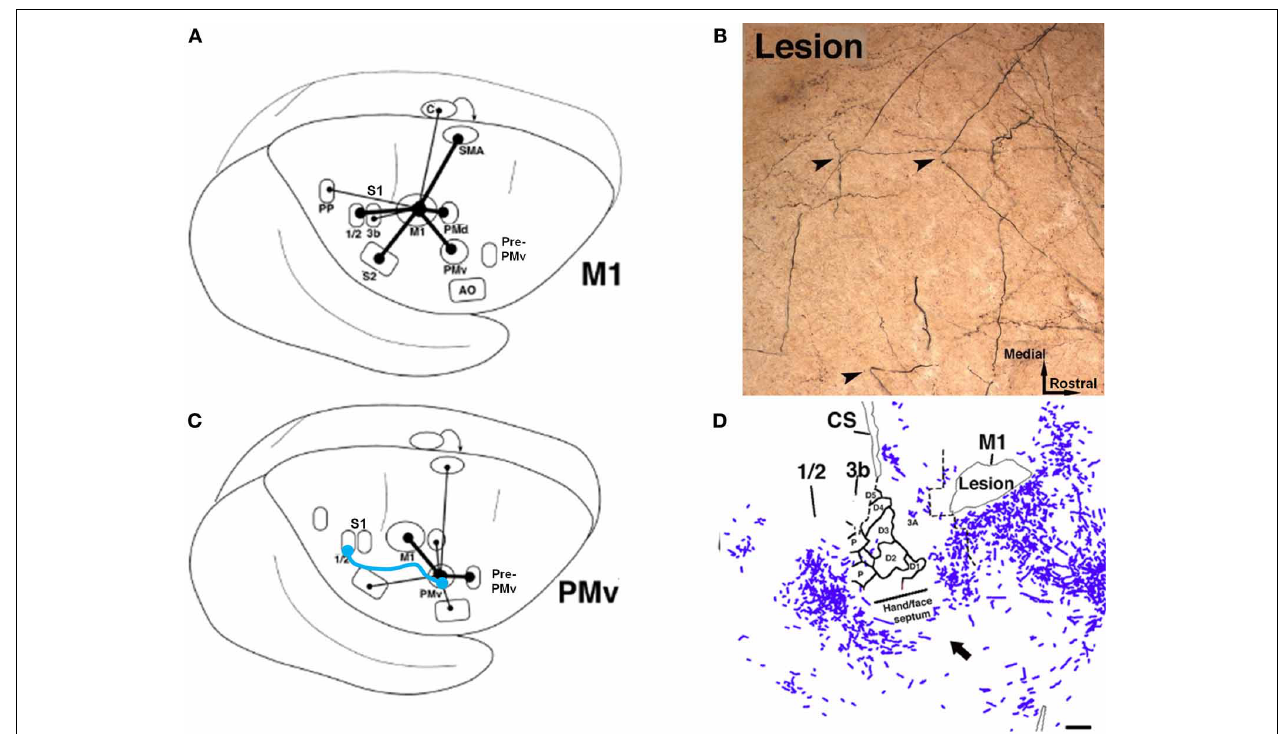
FIGURE 6 | Rewiring of corticocortical connections after ischemic infarct. (A) In normal healthy squirrel monkeys, the primary motor cortex (M1) has dense reciprocal connections with both the premotor cortex (PMv, PMd, SMA) as well as the primary somatosensory cortex (S1) and the second somatosensory area (S2). (B) In addition to M1, the ventral premotor cortex (PMv) has dense connections with a rostral area called pre-PMv. PMv has moderate connections with S2, but negligible connections with S1.